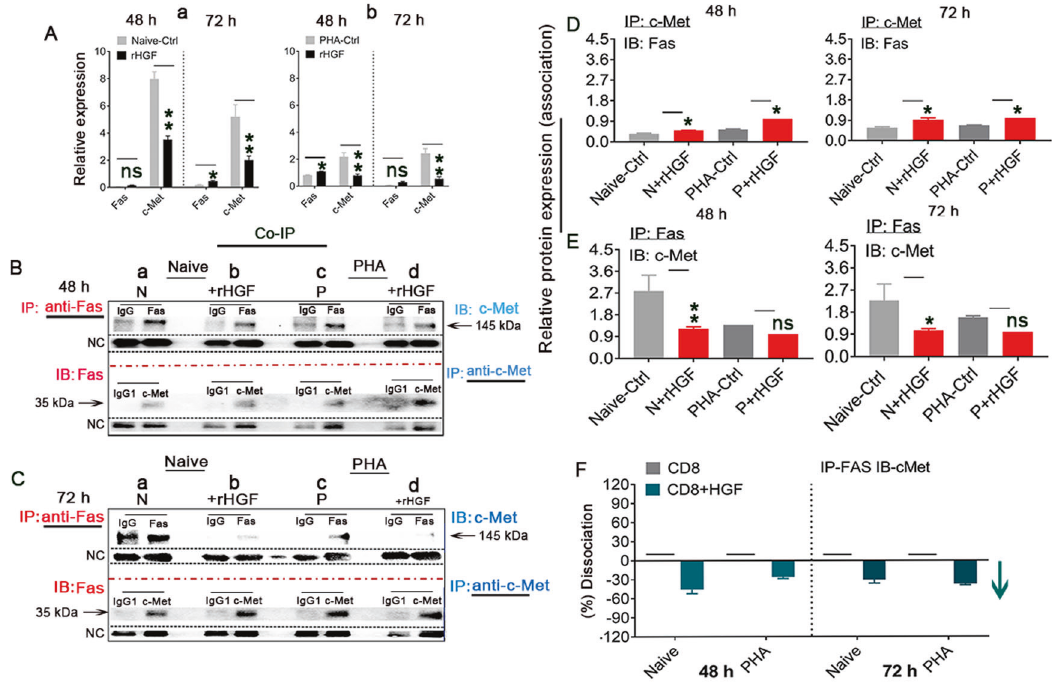
Fig. 4 rHGF regulates the c-Met/Fas molecular mode in naive and PHA-stimulated msCD8 + T cells. A qRT ‒ PCR analysis of Fas and c-Met expression in naive (a) and PHA-stimulated (b) msCD8 + T cells 48 and 72 h after 400 ng/mL rHGF administration, n = 6. B , C A Co-IP assay was performed by IP with Fas or c-Met antibody followed by IB using an af fi nity-puri fi ed anti-c-Met-Ab or anti-Fas-Ab to evaluate the association between c-Met and Fas on naive (a, b, n = 3) and PHA-stimulated (c, d, n = 3) msCD8 + T cells in the presence (b, d) or absence (a, c) of 400 ng/ mL rHGF treatment for 48 h ( B (a – d)) and 72 h ( C (a-d), n = 3/naive and PHA groups). D Quanti fi cation of the association between c-Met and Fas by IP with c-Met antibody followed by IB for Fas performed at 48 and 72 h ( n = 6). E IP with Fas antibody followed by IB for c-Met performed at 48 and 72 h ( n = 6). F Analysis of the dissociation rate of c-Met from Fas after 48 and 72 h of treatment with 400 ng/mL rHGF (the values of the samples marked with short lines were precisely 0). The data are presented as the means ± SDs of at least three independent experiments; original magni fi cation = ×400; scale bar = 200 µm. The asterisks indicate a statistically signi fi cant difference; * p < 0.05 and ** p < 0.001 vs. Naive-Ctrl and PHA-Ctrls; ns represents no signi fi cance (Student ’ s t